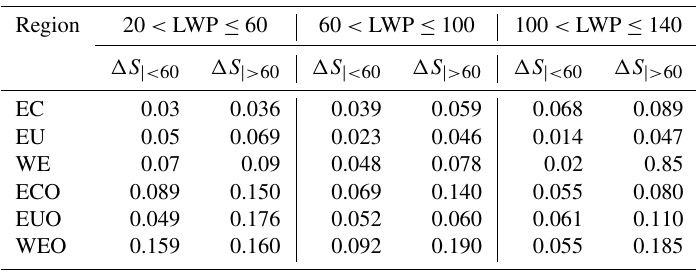
Table 1. The differences between the slope of CER versus aerosol loading (AOD for land, AI for ocean) in PCL and in overcast retrievals in the case of CF > 60% ( (cid:49)S | > 60 ) and CF < 60% ( (cid:49)S | < 60 ) under three LWP bins (gm − 2 ).